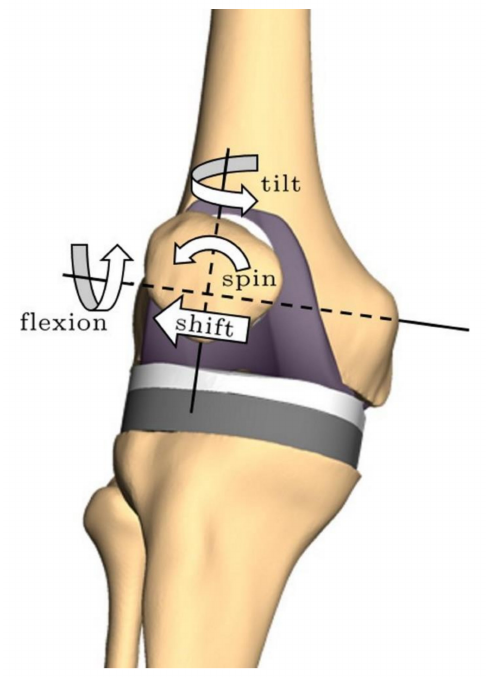
Figure 4. Patellar rotations and patellar shift. Shift along, and flexion around, femoral flexion axis, tilt around patellar proximo-distal axis, and spin around a floating axis orthogonal to the first two axes. Arrows are pointing to positive directions (basic image for this figure from model presented in